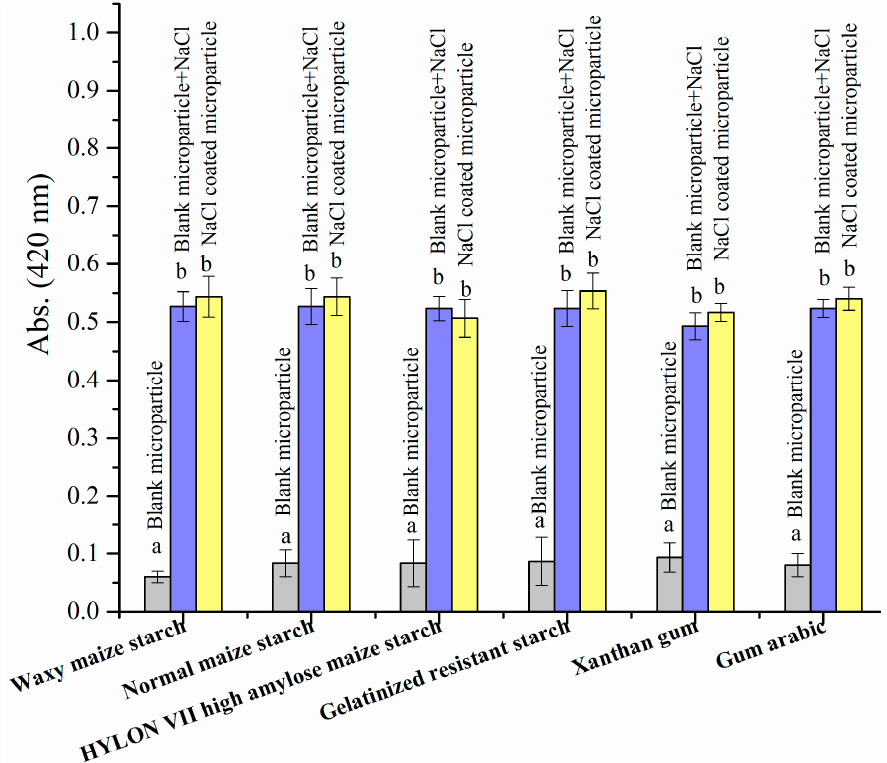
Figure 6. Extent of browning (absorbance at 420 nm) in the model systems prepared with different formulations (refer to Table 1 for the formulations). Values with the same letter within a column are not significantly different ( p > 0.05, Duncan’s test).